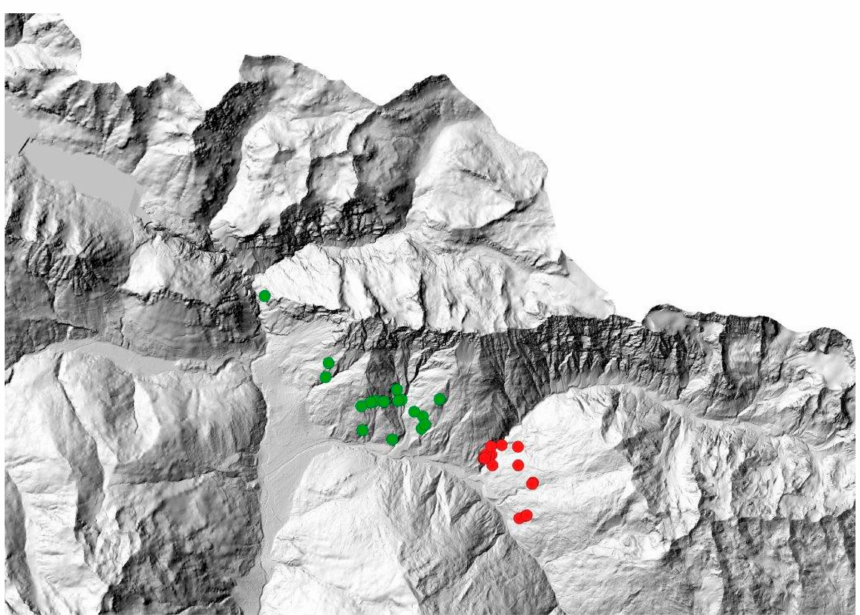
Figure 2. Localization of red deer cullings in Valfurva. Red circles represent individuals culled in the South-East (SE) area; green circles represent individuals culled in the North-West (NW)